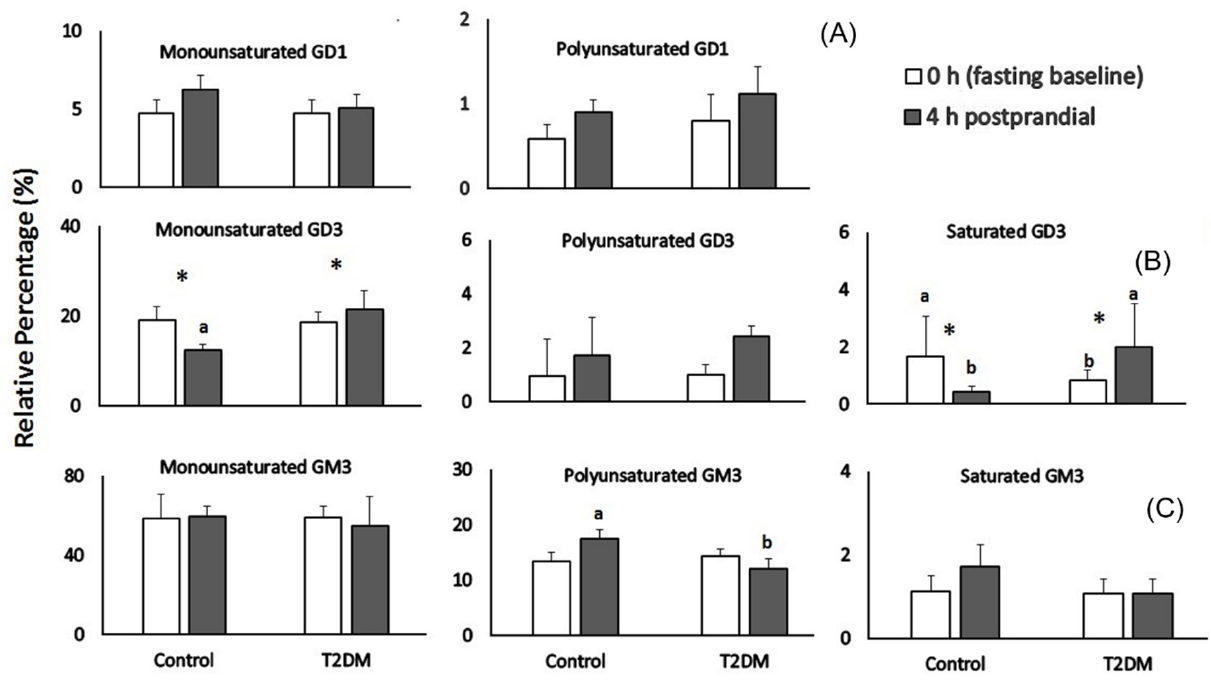
Figure 2. Gangliosides present in plasma at fasted and 4 h postprandial. ( A ) Percentage of mono-, poly-unsaturated GD1 ganglioside species in plasma found at fasting (baseline) and 4 h postprandial in control and diabetic subjects. ( B ) Percentage of mono-, poly-unsaturated and saturated GD3 species in plasma found at fasting baseline and 4 h postprandial timepoint in control and diabetic subjects. ( C ) Percentage of mono-, poly-unsaturated and saturated GM3 ganglioside species in plasma observed at fasting baseline and the postprandial in control and diabetic subjects. Low and high fat diet treatments were combined in subsequent analysis since no significant difference was detected in these groups. Data represent mean ± SD. Letters ( a,b ) indicate significant difference at p < 0.05 when individual ganglioside species are compared between control and T2DM subjects and symbol (*) indicate significant difference at p < 0.05 when individual ganglioside species are compared at 0 and 4 h time periods in the same group. Monounsaturated GD3 species ( p < 0.01) and polyunsaturated GM3 ( p =